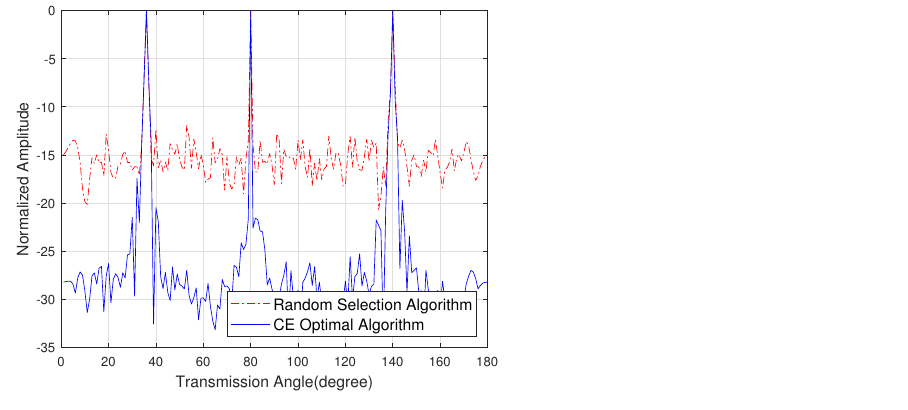
Figure 9. The sidelobe energy of the emission pattern with the unknown channel state information of the eavesdropper.